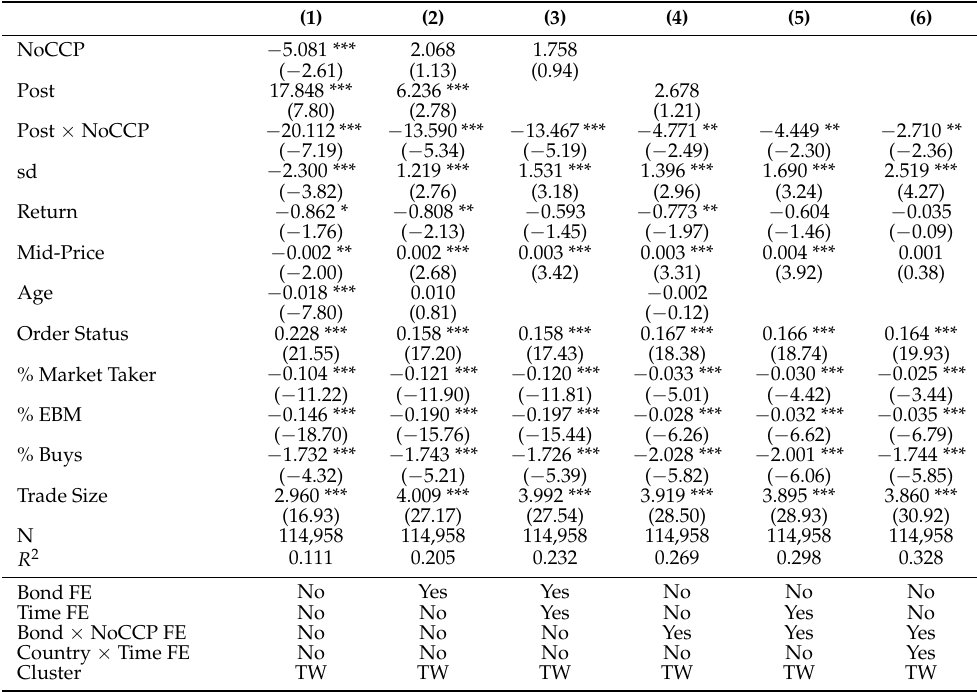
Table 5. Difference-in-difference in EUR